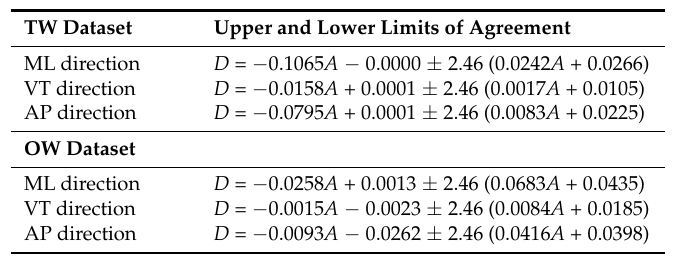
Table 4. Regression equations of the difference ( D ) between the methods on the average ( A ) of the two methods, which provide the upper and lower LAs for each cyclical component of velocity.